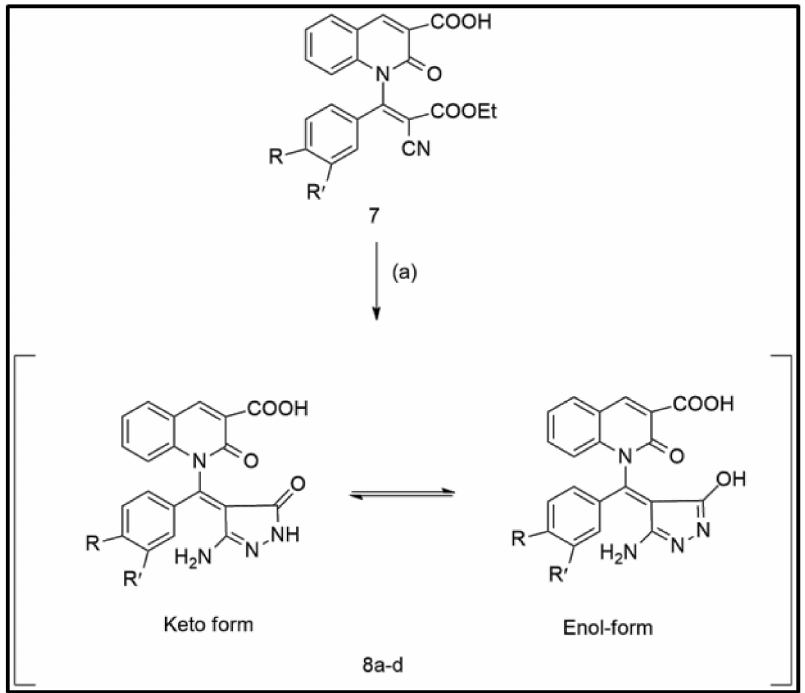
Scheme 3. Synthesis of 2-oxo-1,2-dihydroquinoline-3-carboxylic acid ( 8a – d ) bearing pyrazole ring. Reagents and conditions: (a) hydrazine hydrate, EtOH/reflux ( a , R 1 = R 2 = H; b , R 1 = OCH 3 , R 2 = H; c , R 1 = OH, R 2 = OCH 3 ; d , R 1 = N(CH 3 ) 2 , R 2 =